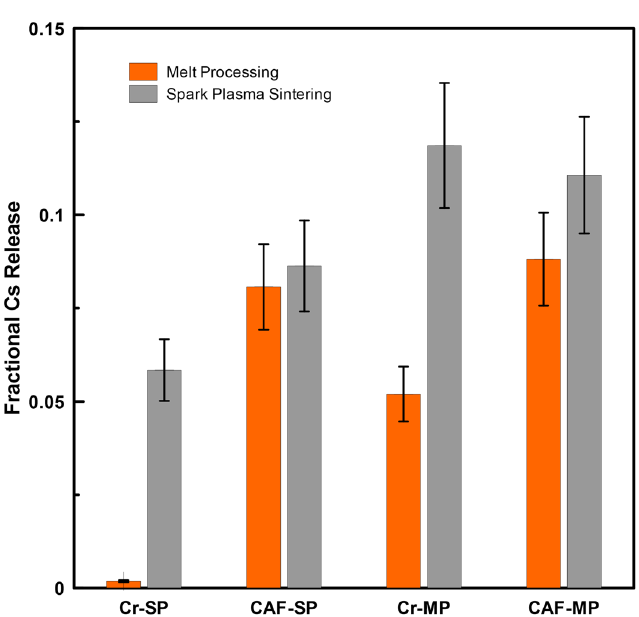
Figure 4. Comparison of fractional Cs release across single phase (SP) and multiphase (MP) ceramics targeting Cr–Al–Fe (CAF) and Cr hollandite compositions prepared via melt-processing and